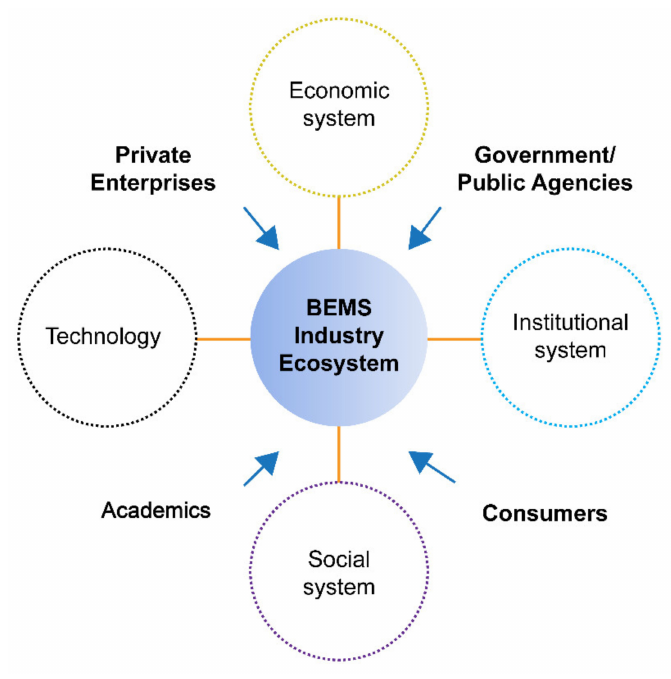
Figure 1. BEMS industry